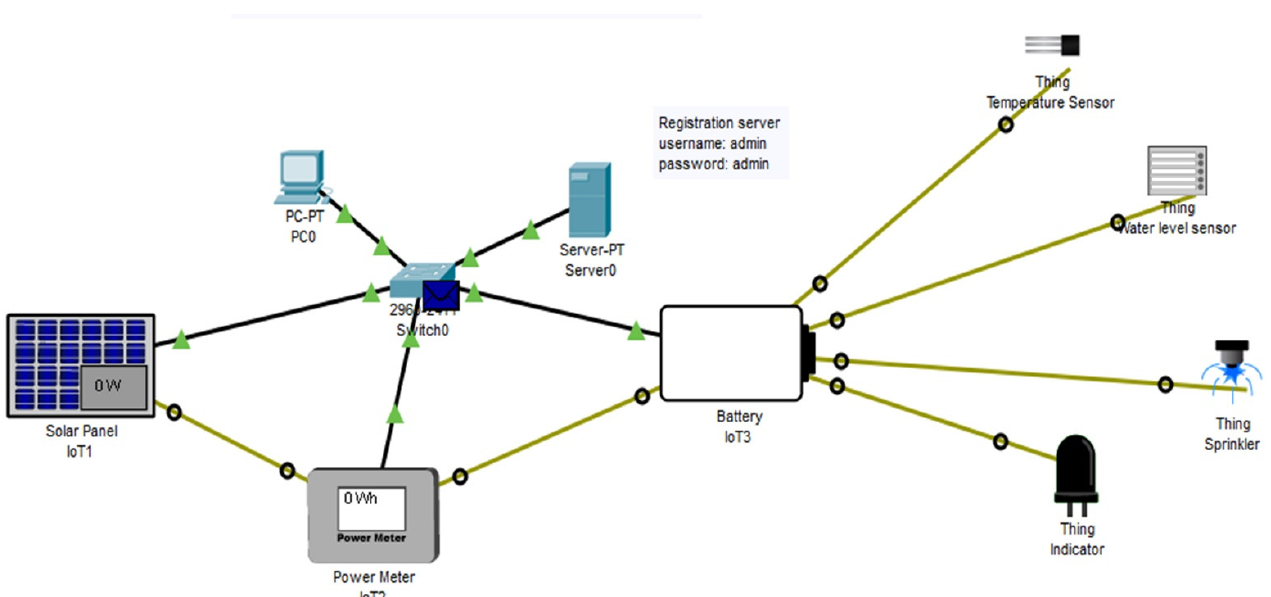
Figure 8. Sensor node communication establishment using LoRa link.